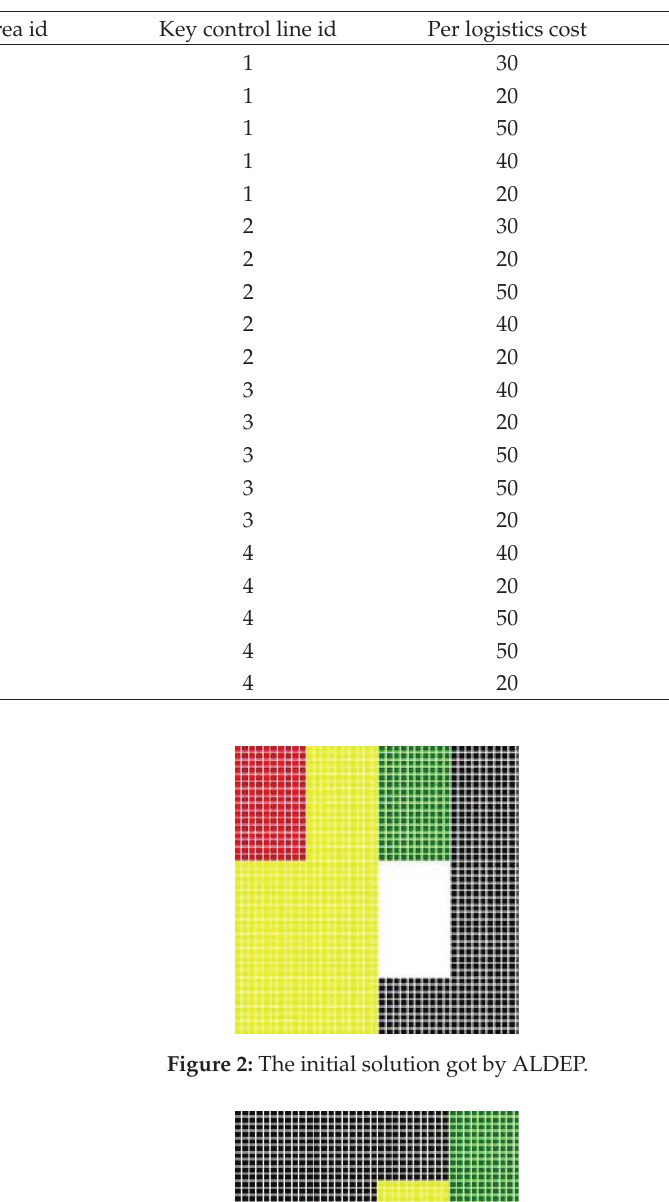
Table 6: Logistics relations table between functional area and key control line.